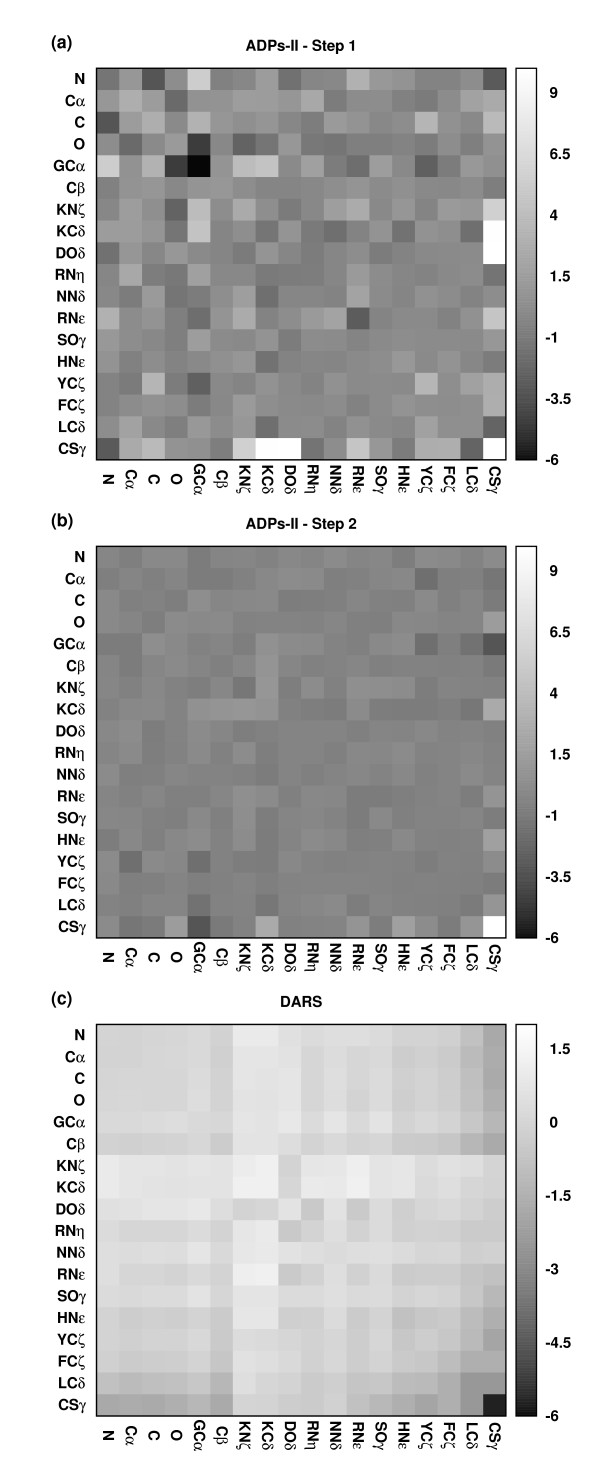
Inter-atomic contact energies for protein-protein docking. The maps corresponding to the first and second step of the presently obtained Atomic Docking Potentials-II are shown in Panels (a) and (b), respectively. Panel (c) shows the map of the DARS potentials [15].